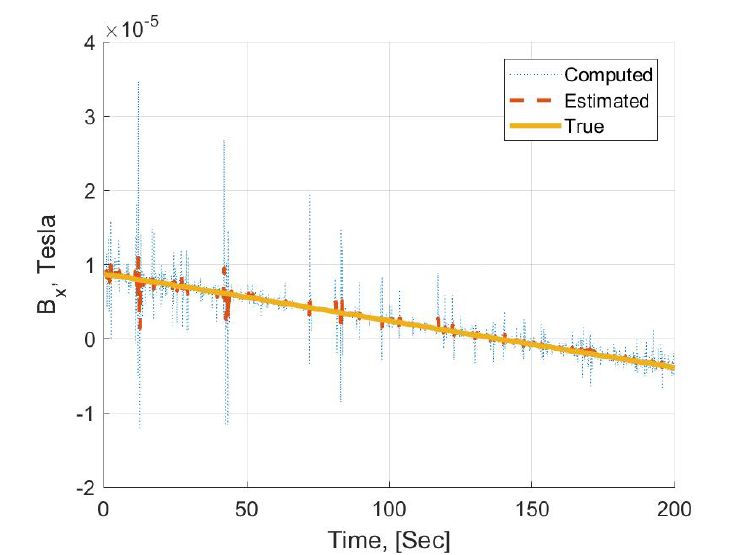
Figure 17. Magnetic field history in the X direction for 1st